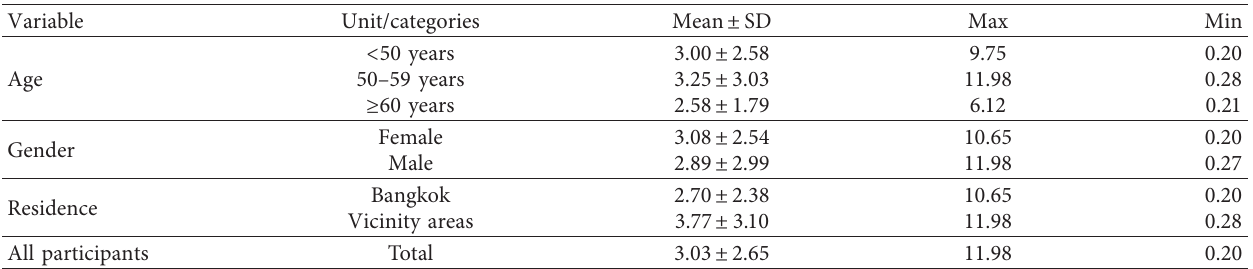
Table 3: Mean intake, maximum intake, and minimum intake of dietary L / Z ∗ for each group of participants.